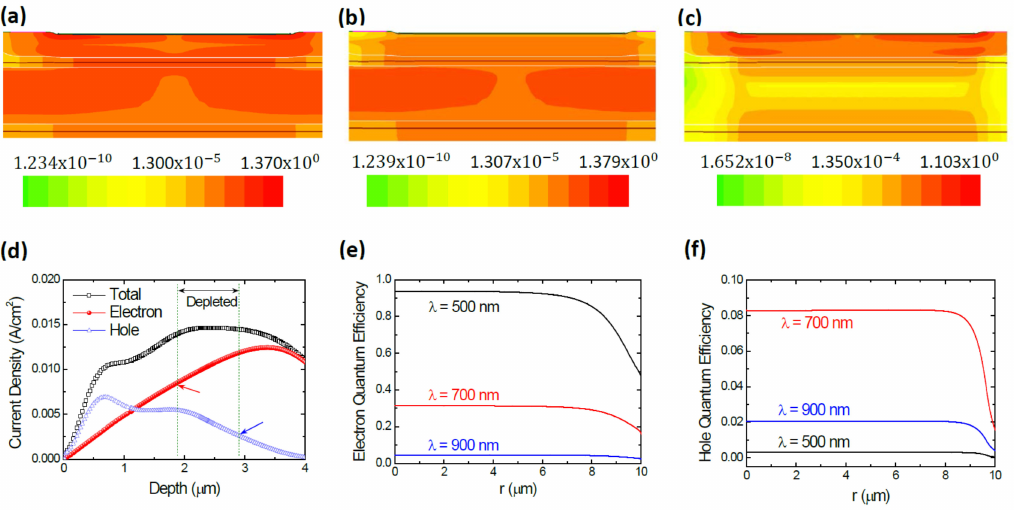
Figure 6. Simulated steady-state current distributions of the device under illumination and the corresponding electron and hole quantum e ffi ciencies. ( a ) 2-D total current density distribution under the 700-nm illumination; ( b ) 2-D electron current density distribution under the 700-nm illumination; ( c ) 2-D hole current density distribution under the 700-nm illumination; ( d ) Cross-sectional 1-D profiles of total, electron, and hole current densities as a function of the depth z at device center under the 700-nm illumination; ( e ) Electron quantum e ffi ciency as a function of the r -position under the 500-, 700-, and 900-nm illuminations; ( f ) Hole quantum e ffi ciency as a function of the r -position under the 500-, 700-, and 900-nm illuminations. The unit of color bars in ( a – c ) is A / cm 2